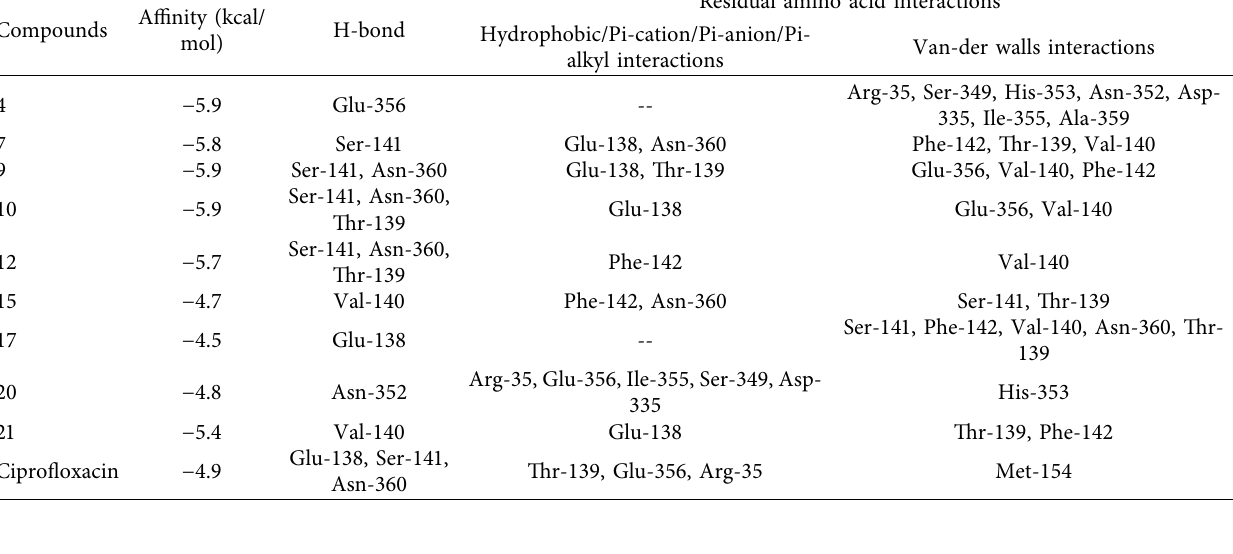
Table 4: Molecular docking results of synthesized compounds against S. aureus topoisomerase IV (PDB ID 2INR).